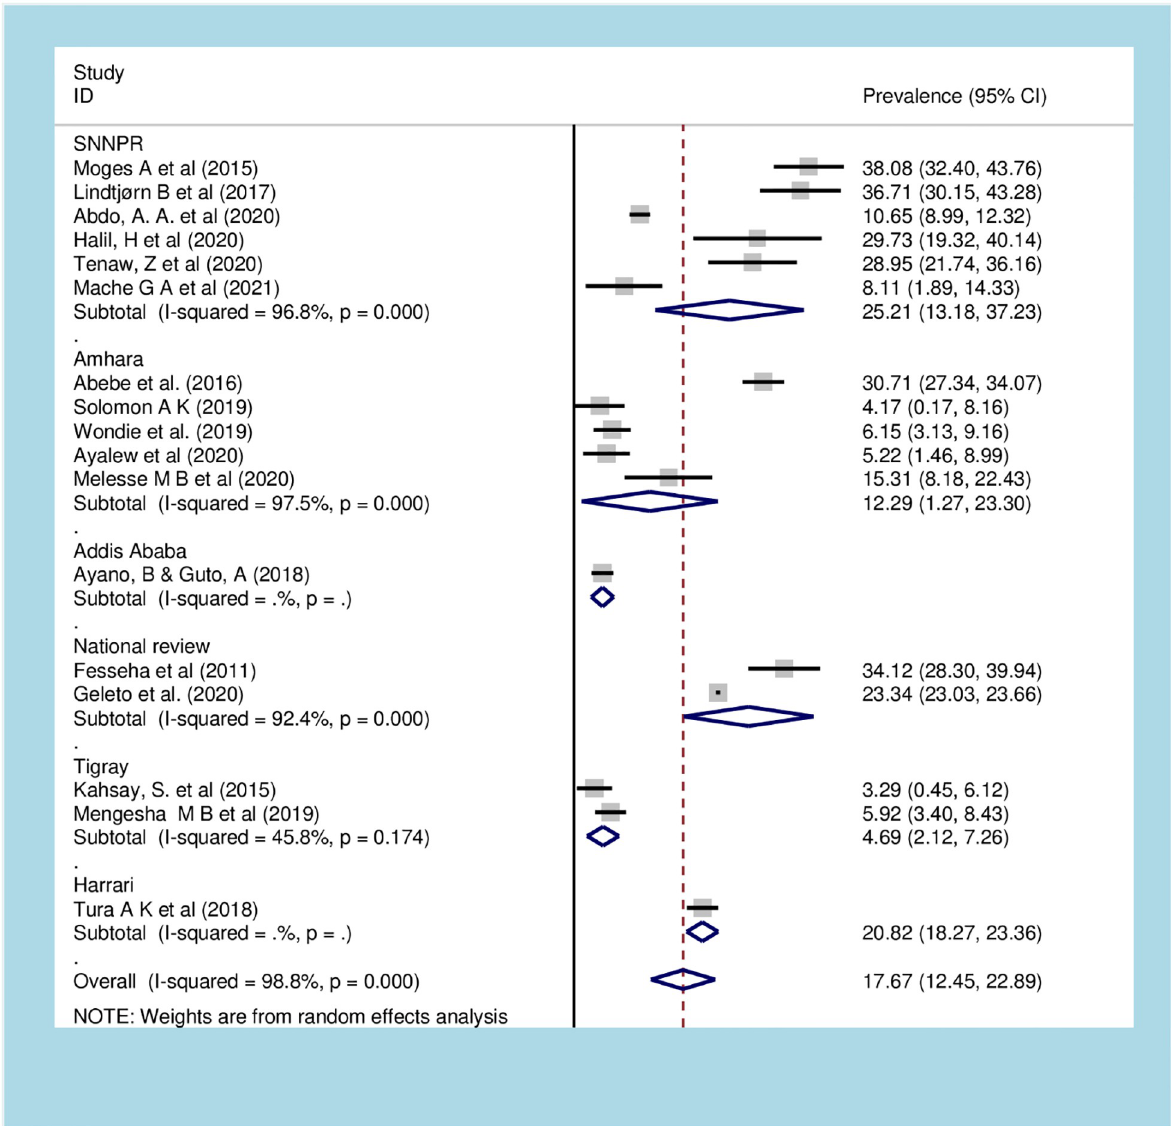
Fig 5. Forest plot of subgroup analysis of cesarean section among obstructed labor women in Ethiopia, 2021.